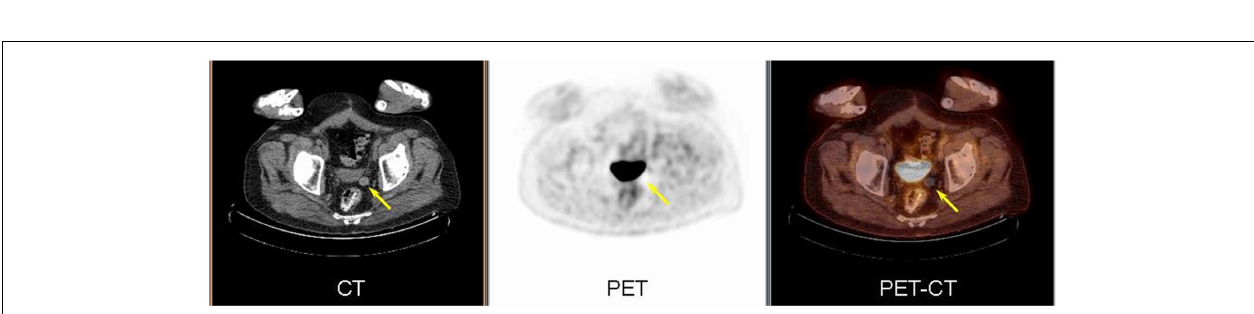
FIGURE 1 | Contrast-enhanced CT demonstrates a well circumscribed round soft tissue density measuring 1.7cm in the right hemipelvis adjacent to the sigmoid colon (white arrows).